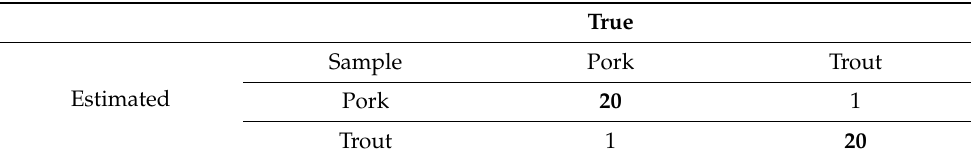
Table 1. Confusion matrix of the classification between meat and fish using the single nanowire gas sensor. True Sample Pork Trout Estimated Pork 20 1 Trout 1 20